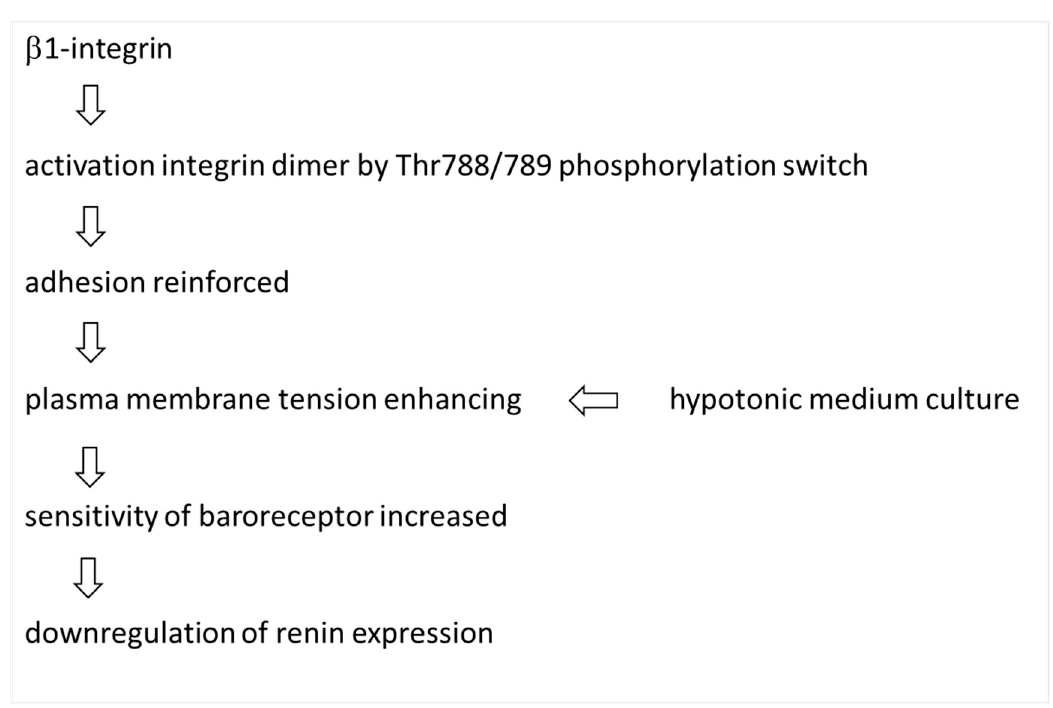
Figure 5. Schematic illustration of the hypothesized mechanisms underlying the regulation of renin by phosphorylated β 1-integrin.